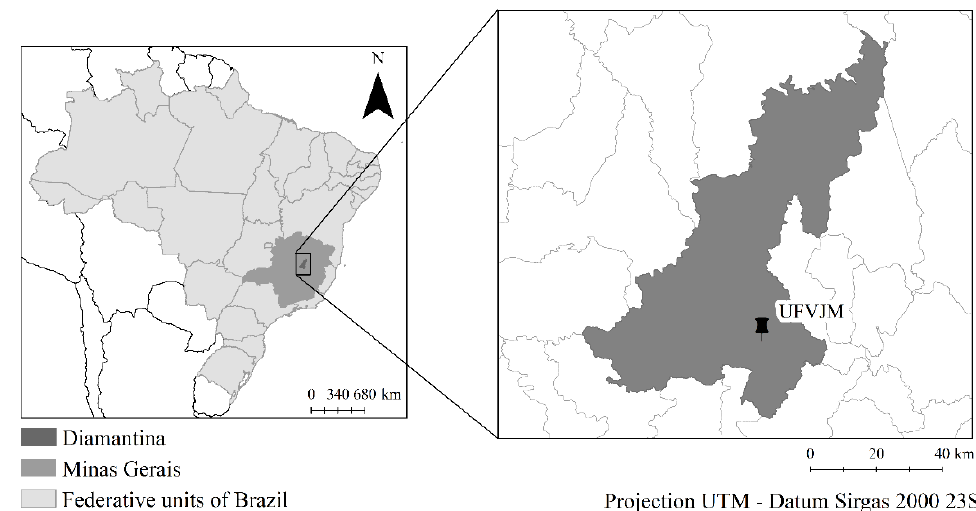
Figure 1. Location of the study site, JK Campus of the Universidade Federal dos Vales do Jequitinhonha and Mucuri (UFVJM) in Diamantina, Minas Gerais, Brazil. The clayey soil used in the experiment was collected at a depth of 0 to 20 cm in the municipality of Curvelo, Minas Gerais, Brazil. Soil analysis was performed at the Viçosa Soil Analysis Laboratory in Viçosa, Minas Gerais, Brazil (Table 1). Table 1. Physicochemical characteristics of soil samples used in the cultivation of the clonal eucalyptus hybrid I144 ( Eucalyptus urophylla × Eucalyptus in competition with grasses).